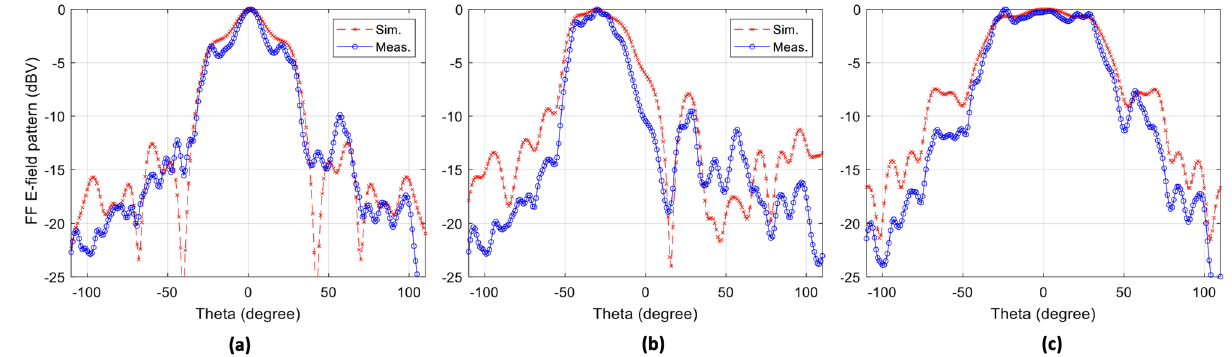
Figure 6. Comparison between simulation and measurement normalized far-field radiation patterns along yz